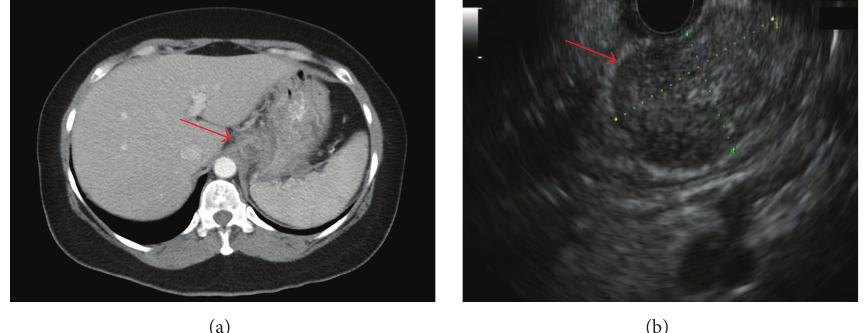
Figure 1: Computer tomography (CT) scan revealing a 1.2 × 1.0cm low attenuation lesion adjacent to the gastric fundus ((a) red arrow); the lesion was also visualized on endoscopic ultrasound ((b) red arrow).